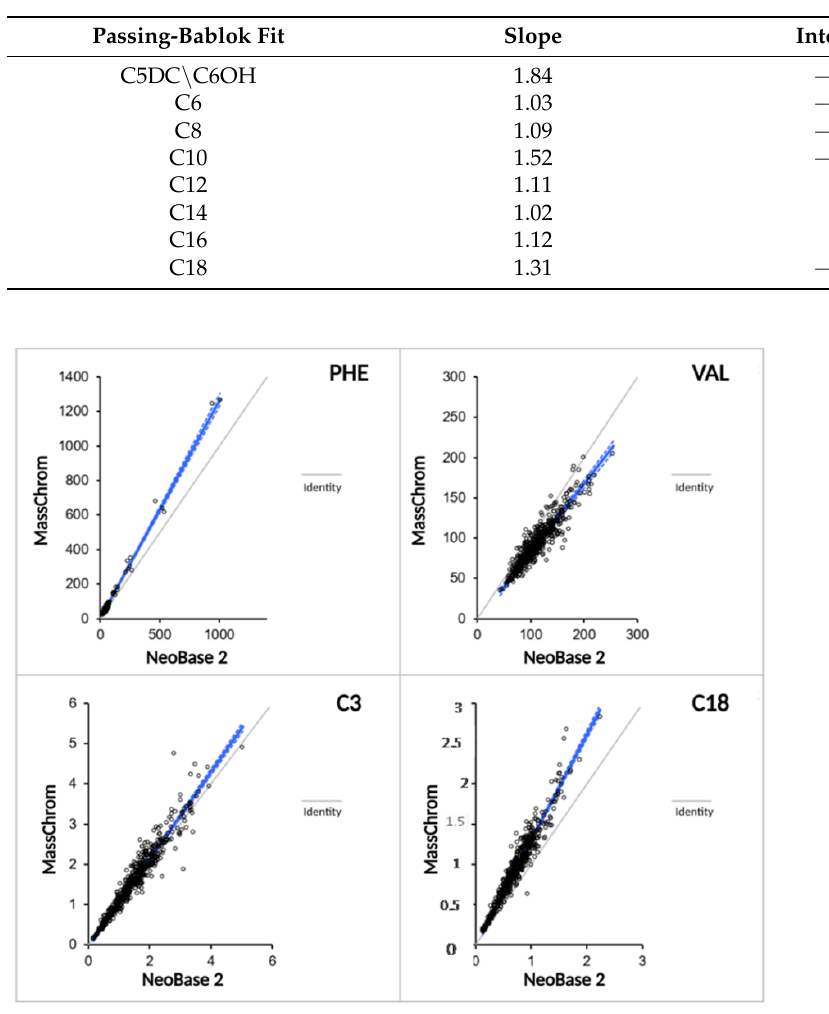
Figure 3. Scatter plots by Passing–Bablok for Phe, Val, C3, and C18 after method comparison between NeoBase™ 2 and MassChrom ® non-derivatized kits.